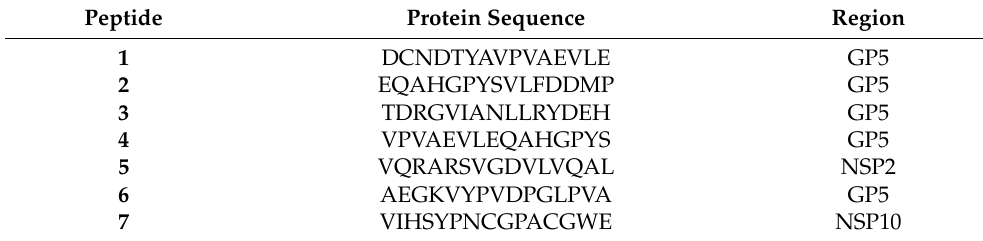
Table 2. EVA peptide sequences and locations .